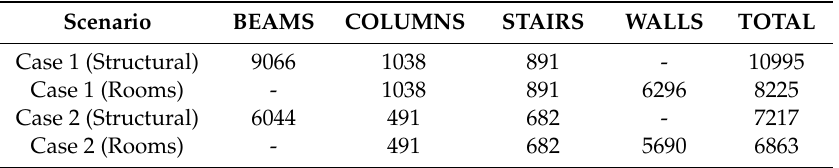
Table 2. Number of units of discretization.